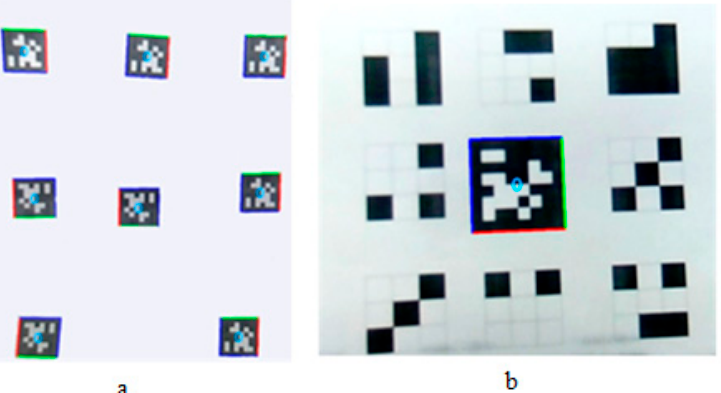
Figure 7. Image detection. ( a ). The detection results of images in different positions or rotations. ( b ). The detection results of anti-interference test.